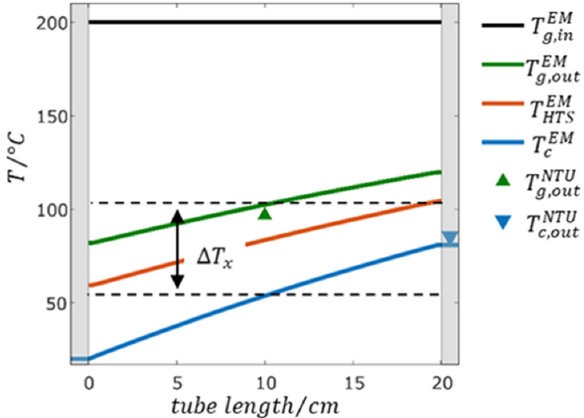
Table 2. Geometric parameters of the heat exchanger (V1) used for parametric study together with baseline values.